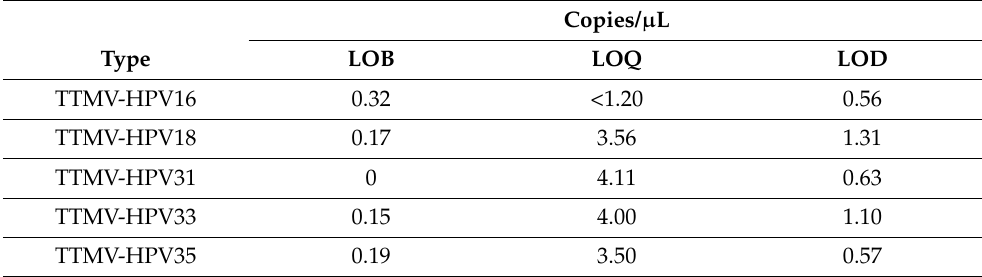
Table 2. Limit of Blank (LOB), Limit of Quantitation (LOQ), and Limit of Detection (LOD) for each TTMV-HPV DNA type given in copies per microliter (copies/ µ